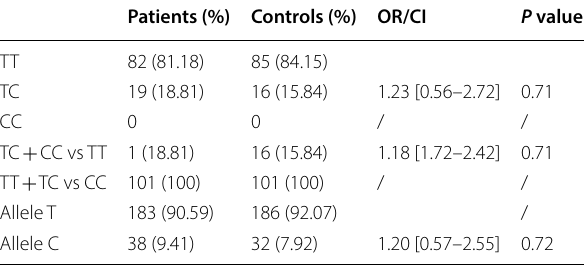
Table 2 Statistical analysis and distribution of CYP1A1 T3801C genotypes and allelic frequencies for PCa patients and controls